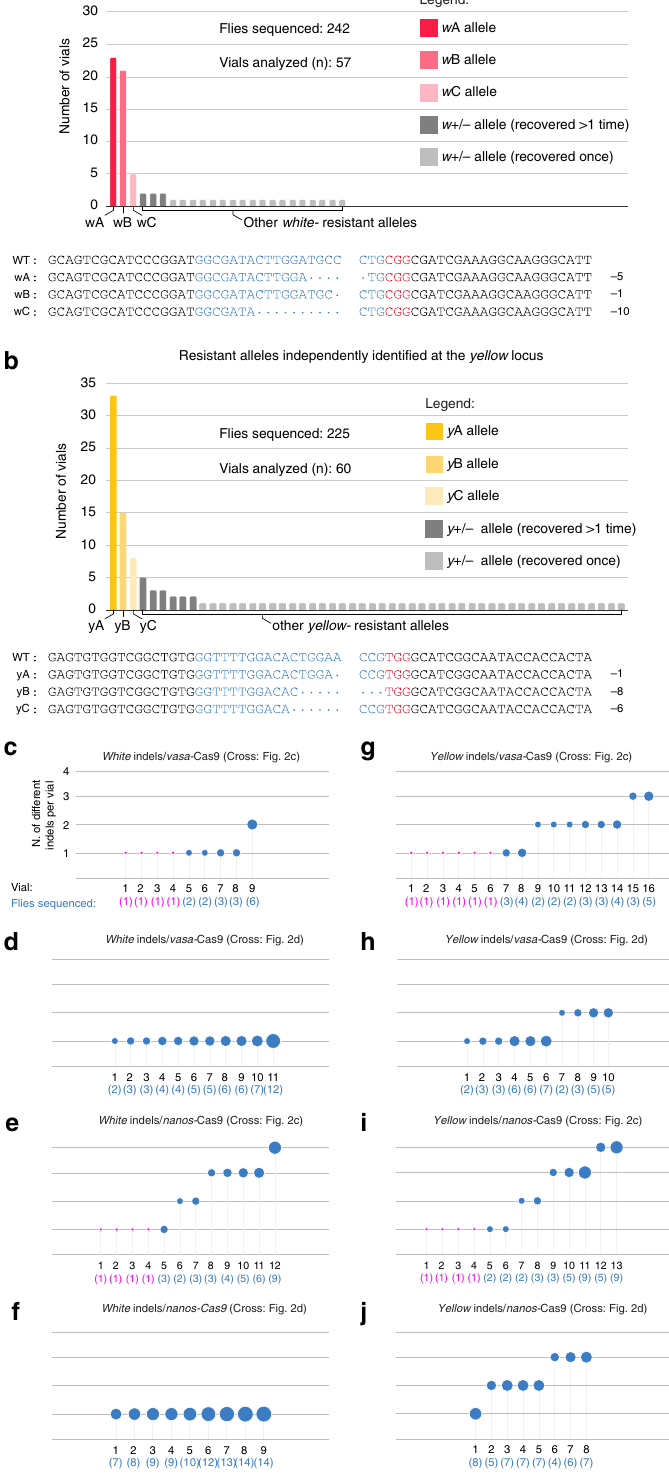
White indels/ nanos-Cas9 (Cross: